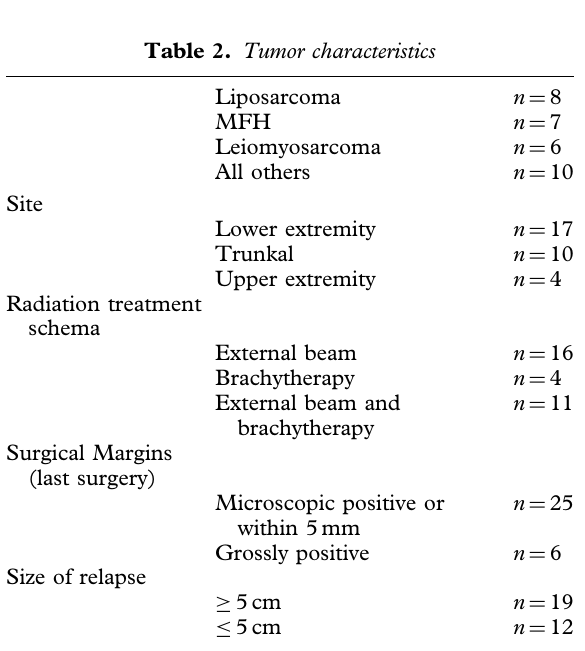
Table 2. Tumor characteristics